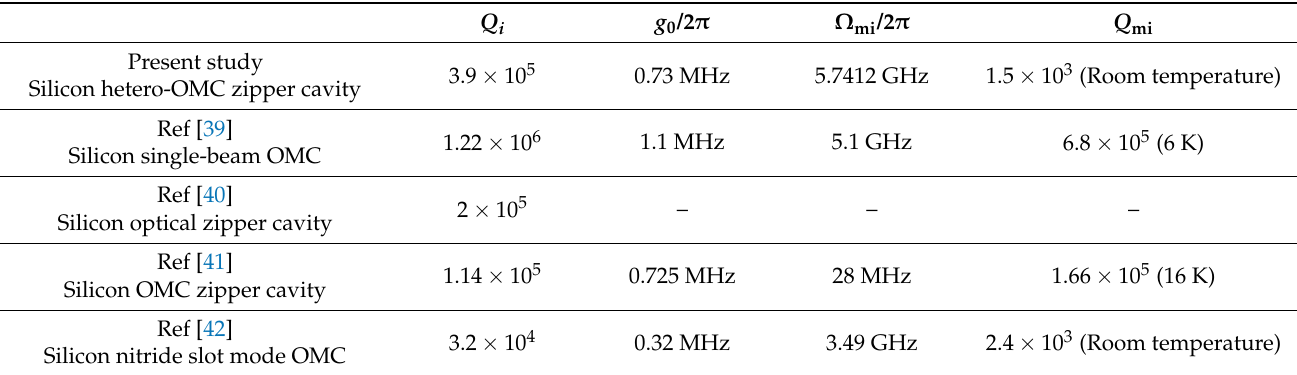
Table 1. Comparison with various optomechanical crystal (OMC)